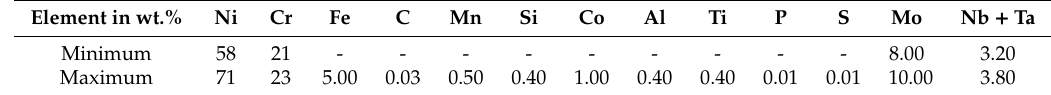
Table 1. Chemical composition of 2.4856 nickel alloy [13].